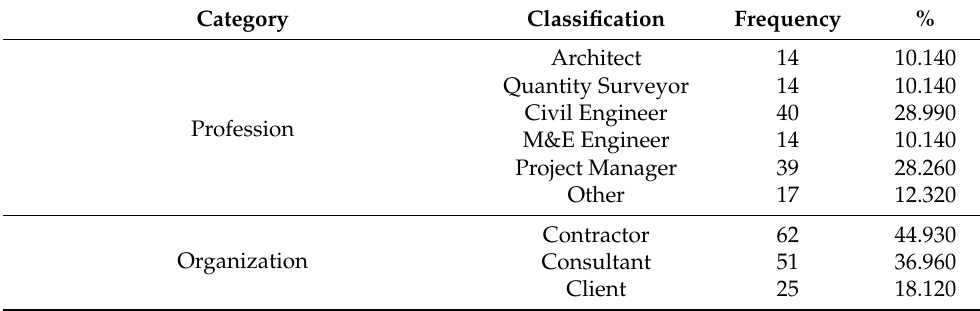
Table 2. Demographic details of participants involved in the